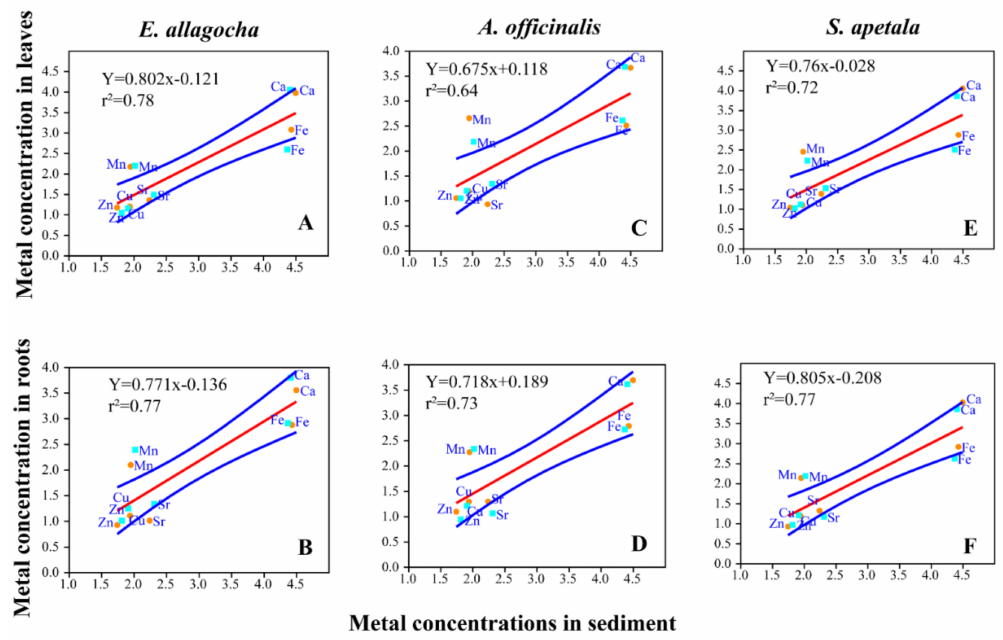
Figure 4. Linear regression model between metal concentration in sediment with the metal concentra- tion in leaves ( A , C , E ) and roots ( B , D , E ) of three mangrove plants ( E. allagocha — A , B ; A. officinalis — C , D ; S. patella — E , F